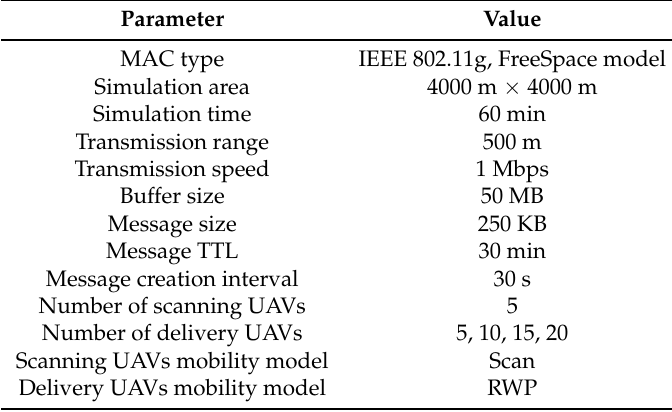
Table 1. Simulation